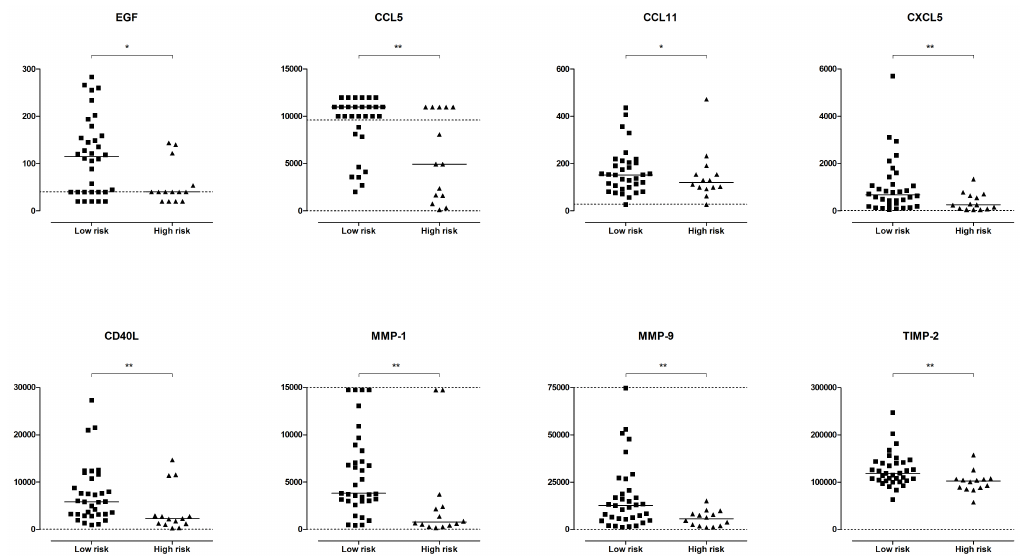
Figure 1. Serum levels of soluble mediators in myelodysplastic syndromes (MDS) patients, a comparison of patients with low-risk (squares) and high-risk (triangles) disease. The figure presents the overall results for those eight mediators showing statistically significant differences between the two groups. The Mann–Whitney U test was used for comparison; p -values * p < 0.05, ** p < 0.01. CCL5 was the only mediator with a p -value lower than p = 0.0013, and considered significant following Bonferroni